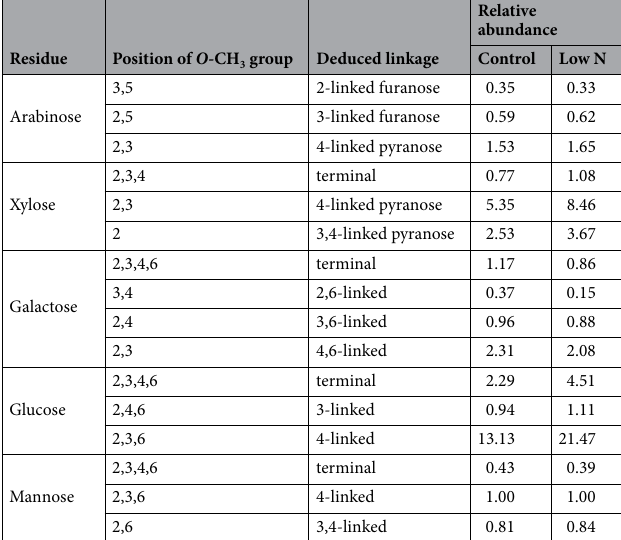
Table 2. Glycosyl linkage composition of the cell walls of hydroponically-grown sorghum seedlings cultivated under control and low-N conditions at 3 weeks after treatment. Relative abundance of the residues was calculated as molar ratio relative to 4-linked mannosyl residue. The averages of duplicate (control) or triplicate (low-N) determinations are shown. Values are the average of two (control) or three (low N) replicate